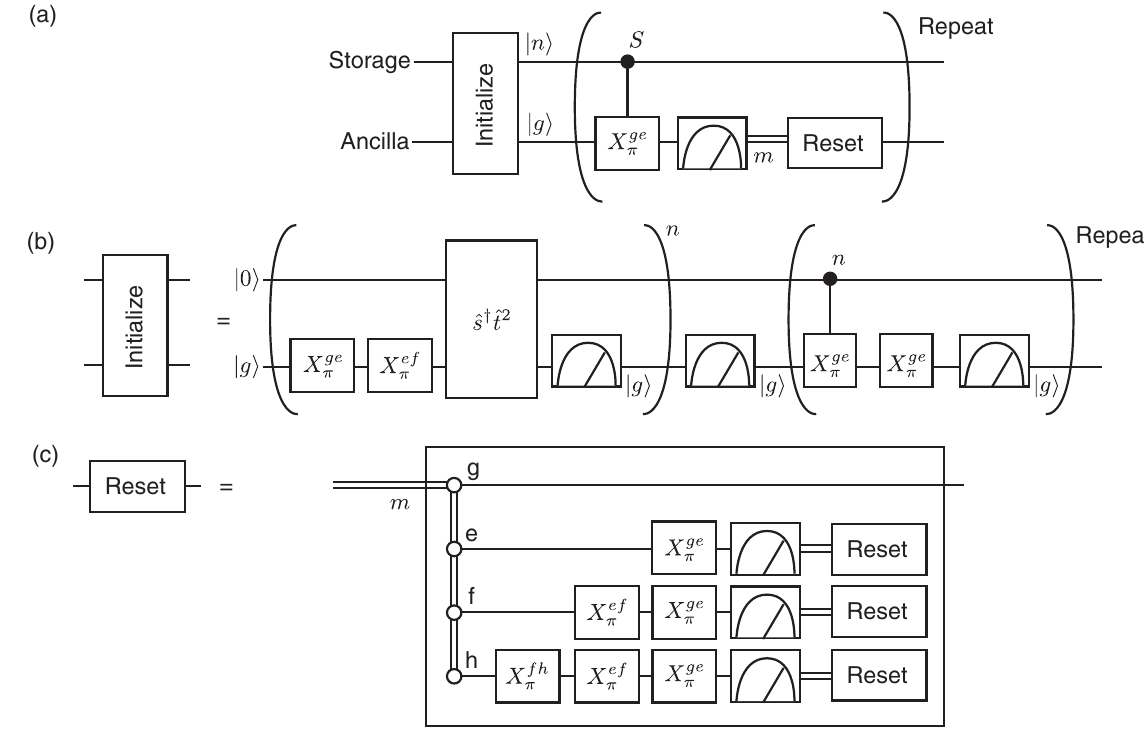
FIG. 4. Schematic of the repeated measurement procedure. (a) Block diagram showing how an encoded bit is measured. We first prepare one of several Fock states j n i in the storage mode. We then perform several readout cycles, each time obtaining an outcome. Each cycle consists of a decode pulse which excites the ancilla conditioned on the encoded bit, followed by a readout and reset of the ancilla. (b) The initialization procedure uses number-selective pulses and ancilla readouts to verify that the correct state has been prepared. This verification is crucial in order to demonstrate a sensitive detection. (c) Each reset consists of a real-time feedforward protocol, which ensures that the ancilla is in its ground state j g i at the end of each